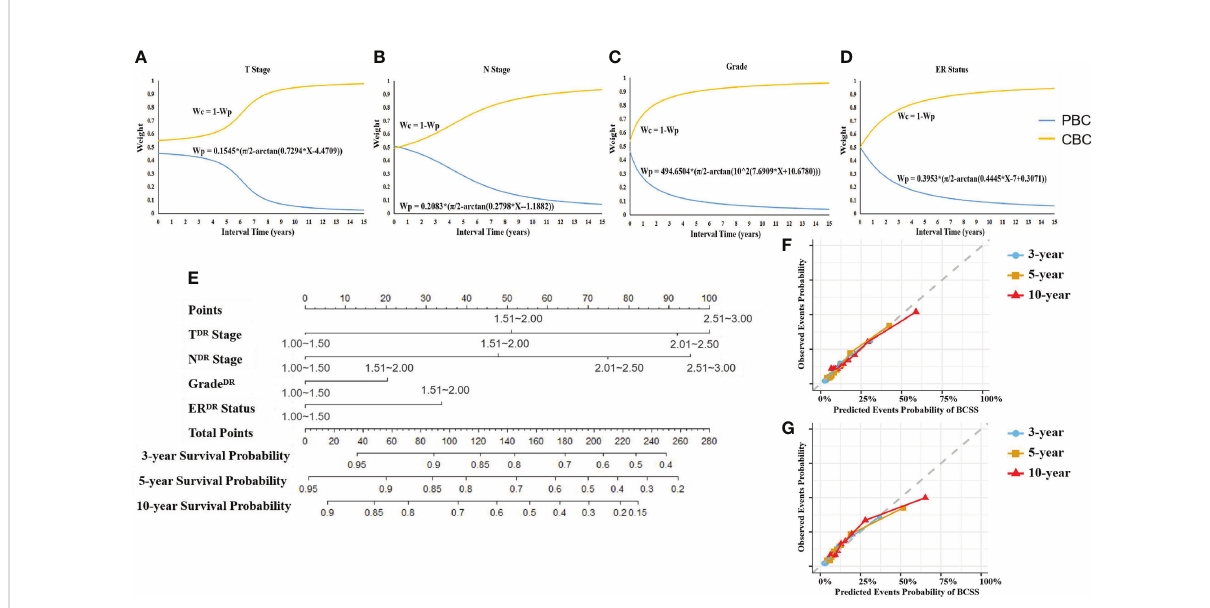
FIGURE 4 Weight of CIF curves on interval time and DR nomogram. (A – D) The weight of T stage (A) , N stage (B) , grade (C) , and ER status (D) belonging to PBC or CBC for prognostic prediction changed with interval time. CIF curves were created to identify the weight of PBC and CBC of the patient with speci fi c interval time when using each character to predict BCCM. Wp, weight of PBC ’ s character. Wc, weight of CBC ’ s character. (E) DR prognostic nomogram for patients with MBBC. Competing risk dimensionality reduction nomogram for predicting the 3-, 5-, and 10-year probabilities of breast cancer – speci fi c survival (BCSS). (F, G) Calibration plots for 3-, 5-, and 10-year probabilities of DR nomogram in the training (F) and validation (G) cohort. The solid line represents equality between the predicted and observed probabilities. With the dots close to the solid line, the plots reveal excellent agreement between the nomogram-predicted probabilities and actual